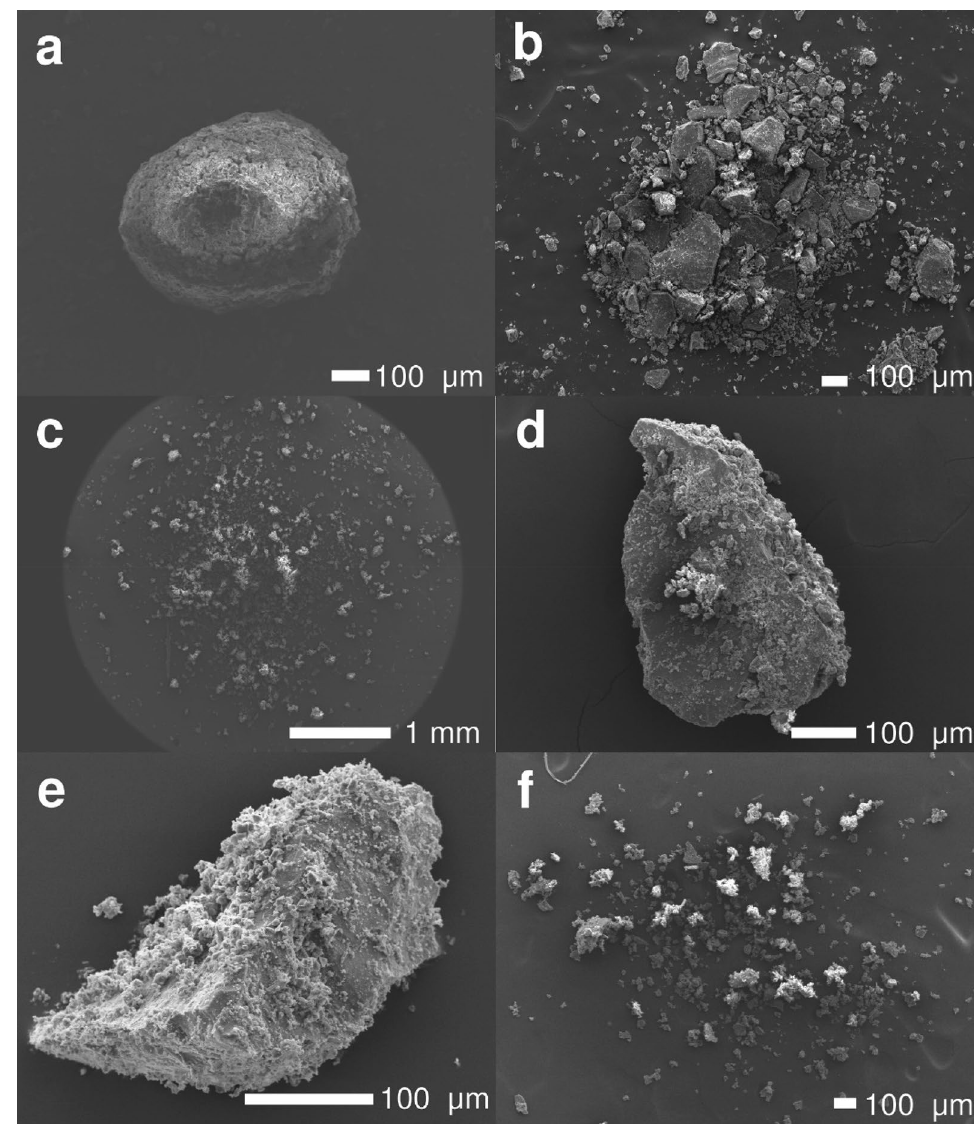
Figure 2. SEM images of the different types of aggregates collected. ( a ) AP1 from eruption I collected at L6; ( b ) AP3 from eruption K collected at L7; ( c ) PC1 from eruption I collected at L6; ( d ) and ( e ) PC2s from eruption C collected at L6; and ( f ) shell of PC3 from eruption K collected at